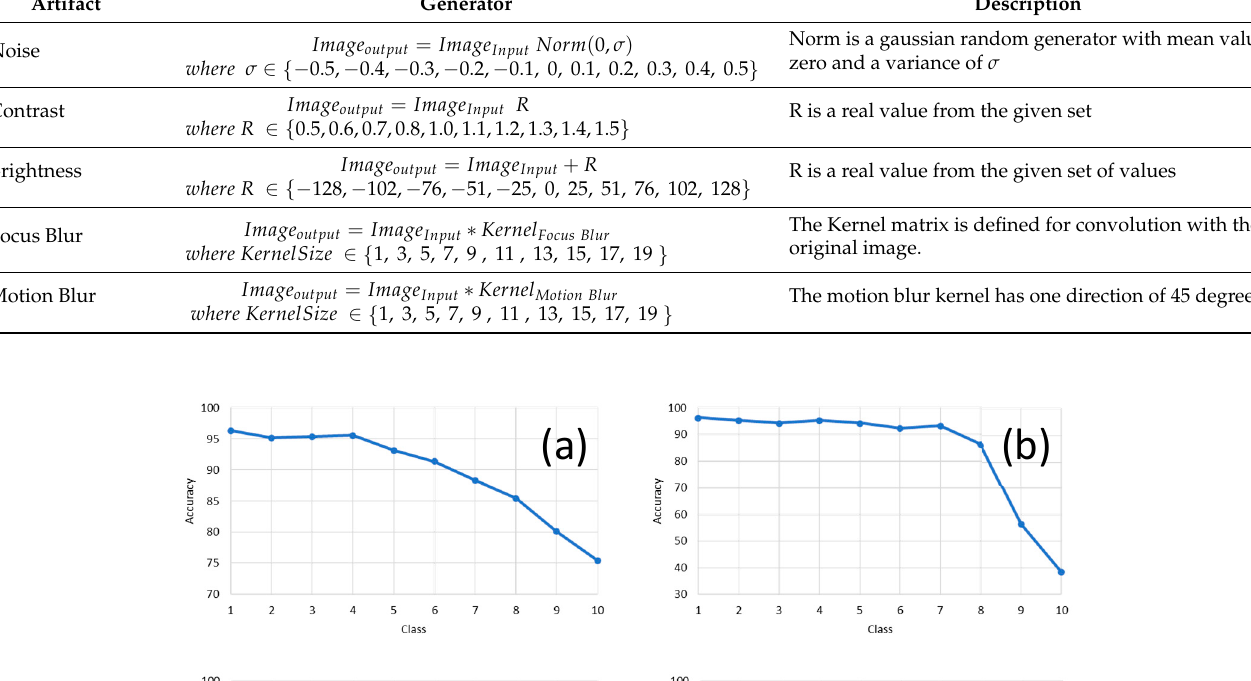
Table 4. Different artifacts related parameter ranges used for stress-testing (as shown in Figure 14) our classifier’s sensitivity. Artifact